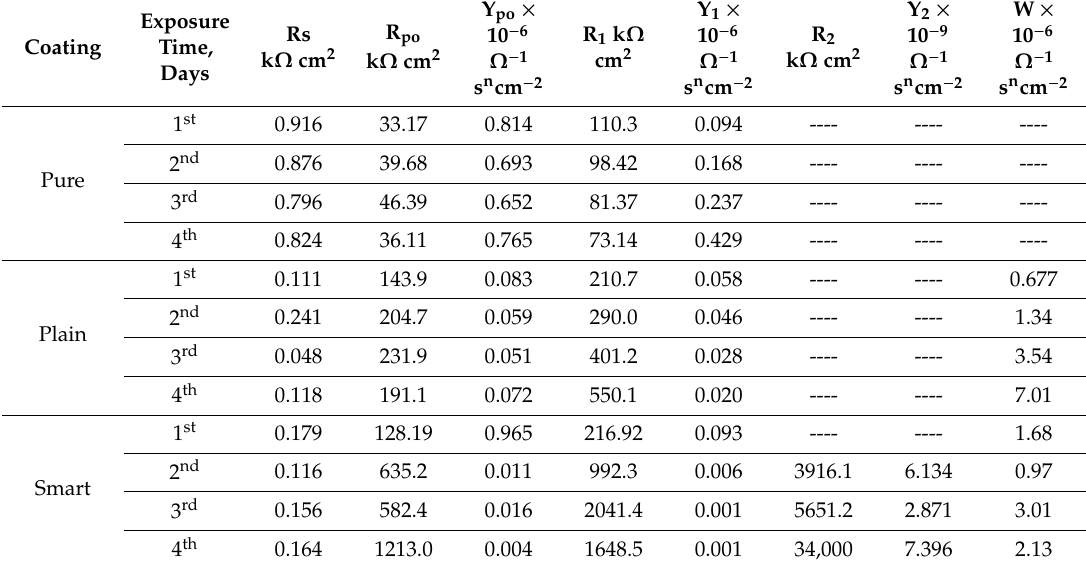
Table 2. EIS parameters for neat coatings, plain coatings, and layered coatings in 3.5 wt% NaCl at room